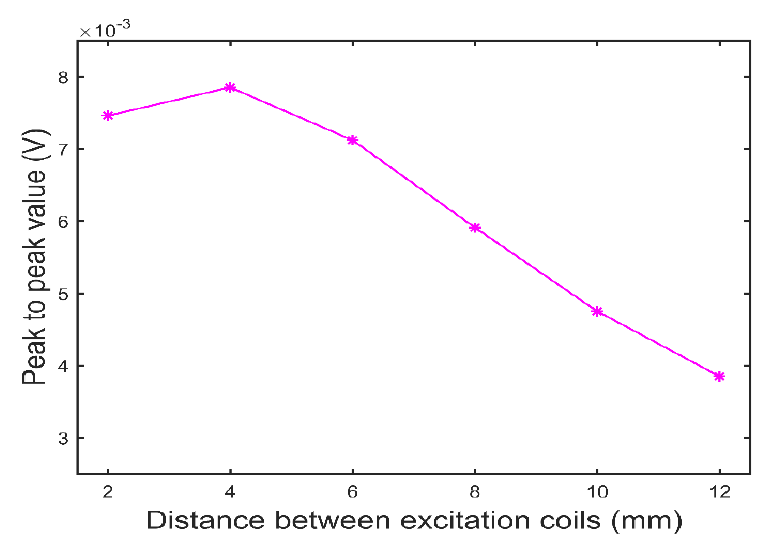
Figure 7. The peak to peak value of crack defect signal as a function of the distance between the excitation coils.